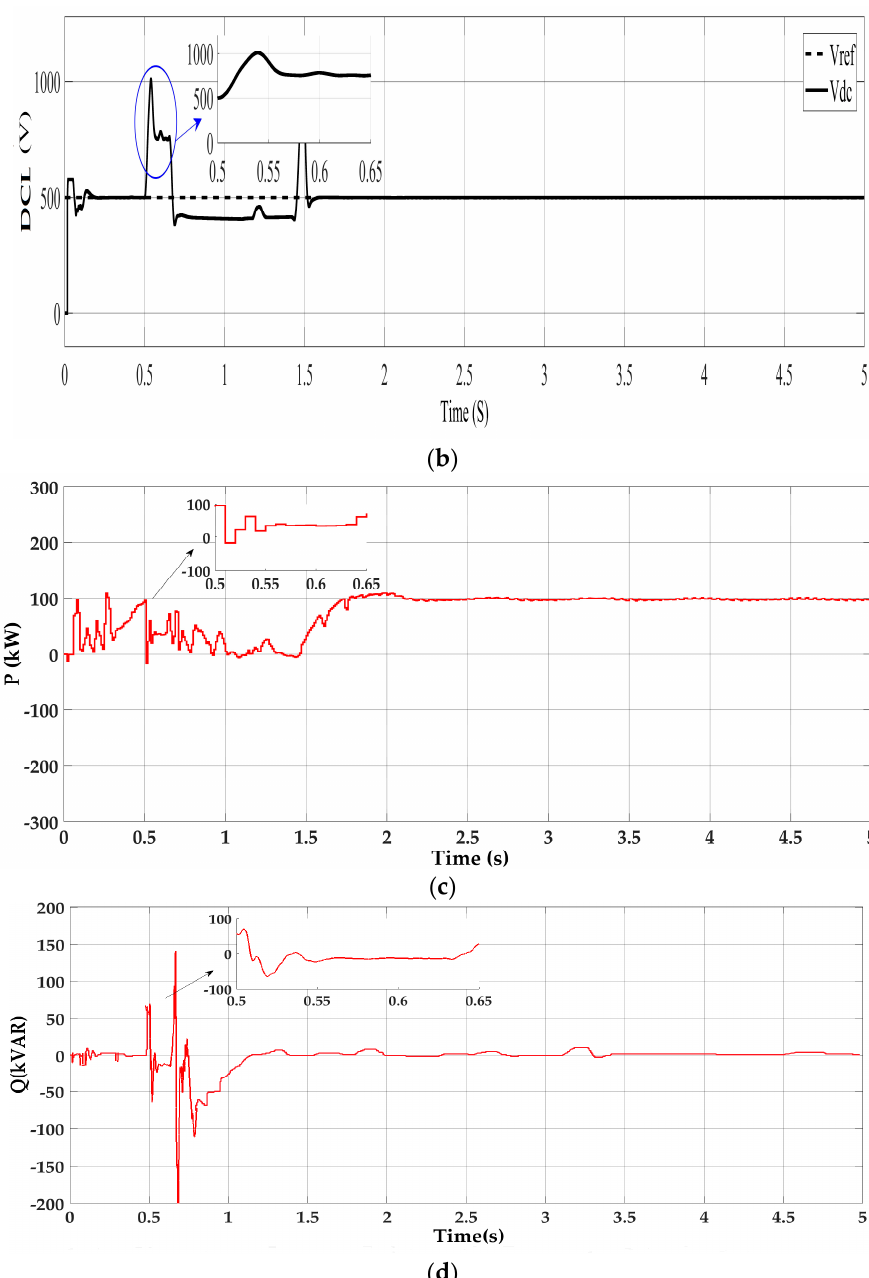
Figure 13. Simulation results of the MPPT control scheme under an asymmetrical fault (2-LG). ( a ) Grid voltage at PCC, ( b ) DC-link voltage (DCL), ( c ) active power (P), ( d ) reactive power (Q).